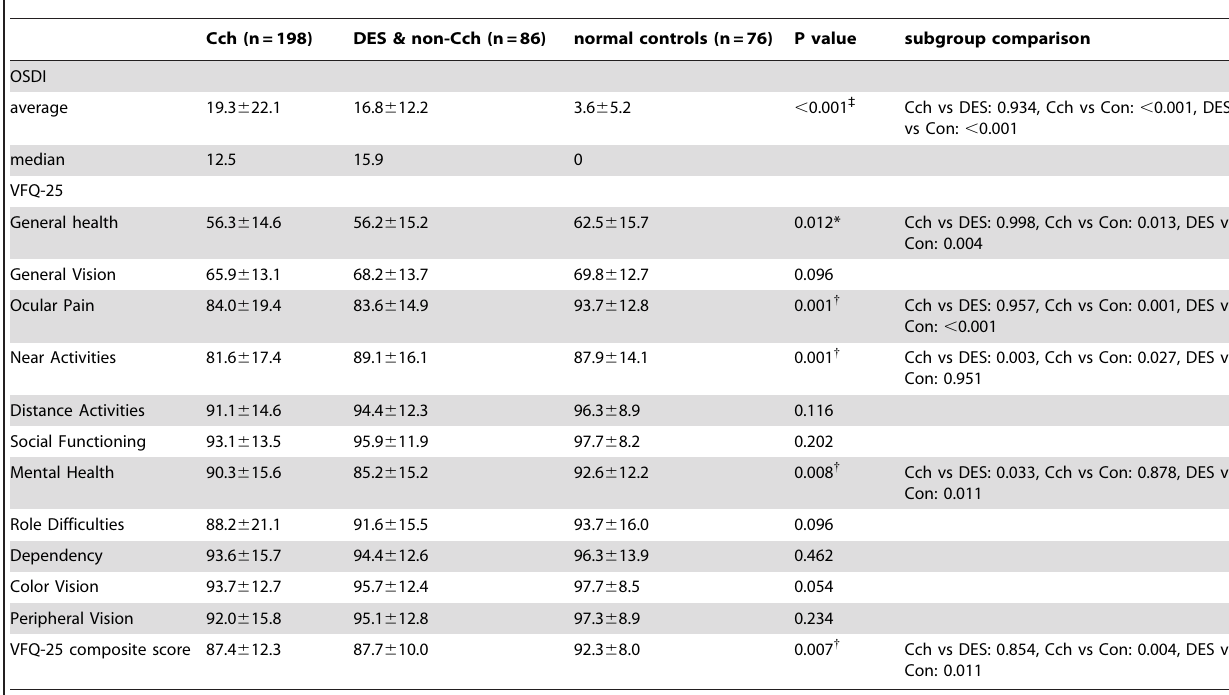
Table 4. The OSDI score, NEI VFQ-25 composite score, and the scores for each VFQ-25 subscale in enrolled subjects.